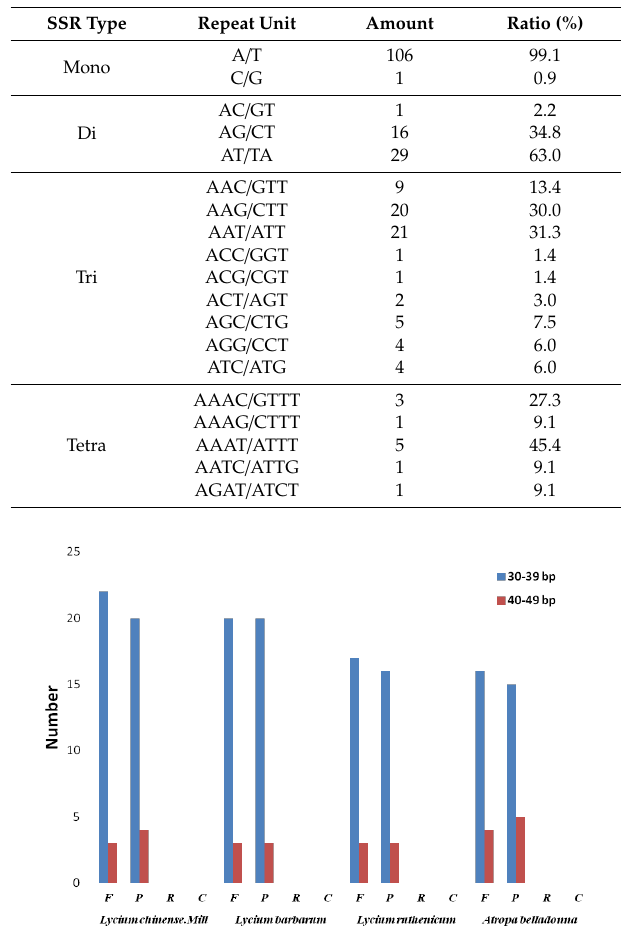
Table 4. Types and numbers of simple sequence repeats (SSRs) in the L. chinense chloroplast genome.